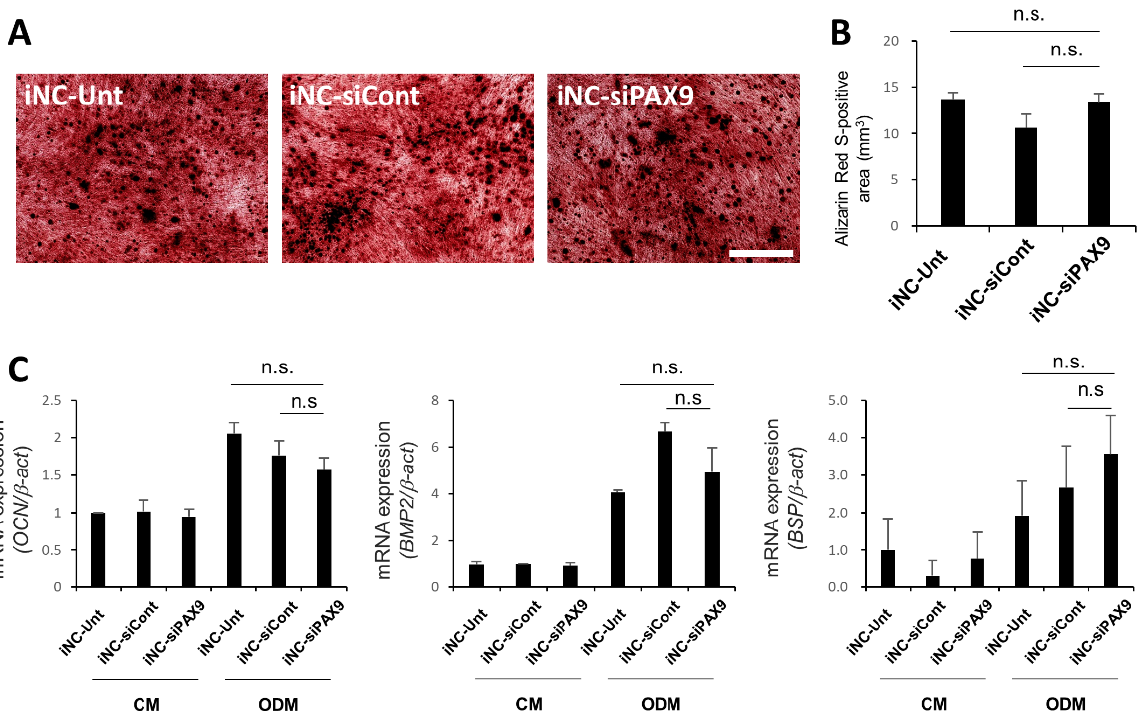
Figure 5. No significant difference in osteoblastic differentiation between iNC-Unt, iNC-siCont, and iNC-siPAX9. ( A ) Representative Alizarin Red S-staining in iNC-Unt, iNC-siCont, and iNC-siPAX9 after 3 weeks of culture in ODM. Bar = 200 µm. ( B ) The area of Alizarin Red S-positive staining in iNC-Unt, iNC-siCont, and iNC-siPAX9 cultured in ODM for 3 weeks. ( C ) Quantitative real time RT-PCR analysis of osteoblast-associated marker genes OCN , BMP2 , and BSP in iNC-Unt, iNC-siCont, and iNC-siPAX9 after 3 weeks of culture in CM or ODM. β -act was used as an internal standard. Data are portrayed as the mean ± standard deviation ( n = 4). CM; control medium (10% FBS/ α -MEM). CM, conditioned medium; iNC, induced pluripotent stem cell-derived neural crest-like cells; ODM, osteoblastic differentiation medium. n.s.: non significant.